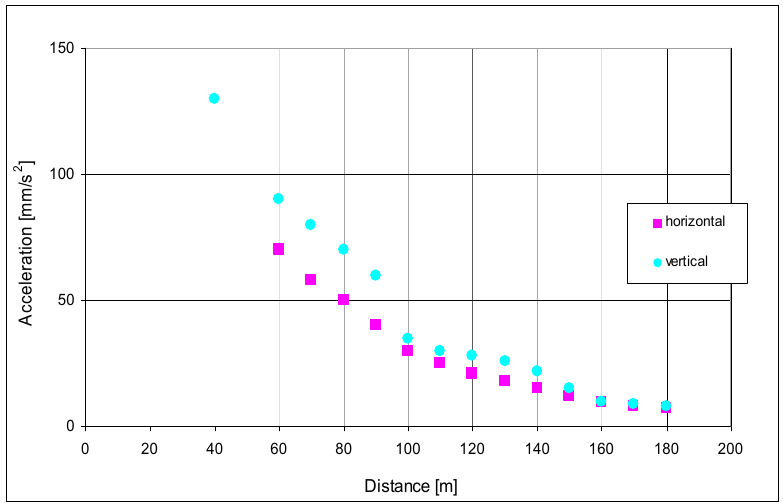
Figure 19. Dependence of acceleration amplitude on the distance from the source (neighborhood of the “Oak Terraces” a housing estate in